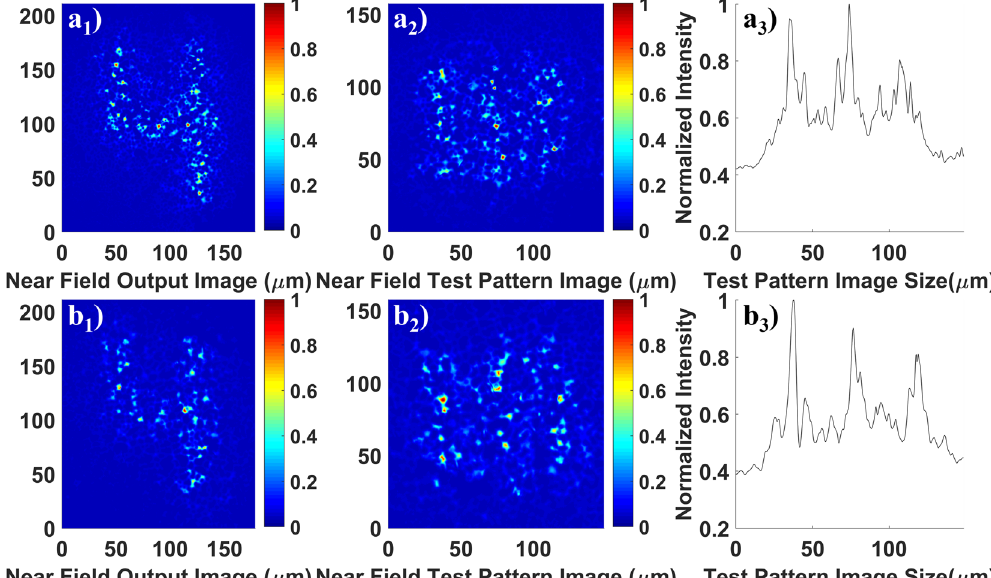
Figure 5. Images of numbers, line elements and the corresponding intensity cross-sections of the line elements after transport through 4.5 cm of the two different GARFs. ( a1 – a3 ) are obtained using a GARF(2) with a maximum of 6.8 μ m 2 in the air hole area distribution; ( b1 – b3 ) are obtained using a GARF(3) with a maximum of 18.5 μ m 2 in the air hole area distribution. The illumination wavelength is 405 nm. As in Figs 3 and 4, the number “4” belongs to group 3 on the resolution target. The line elements in ( a2 ) belong to group 4 number 6 on the resolution target. The line elements in ( b2 ) belong to group 4 number 5. The visibility values are 0.33 for ( a3 ) and 0.32 for ( b3